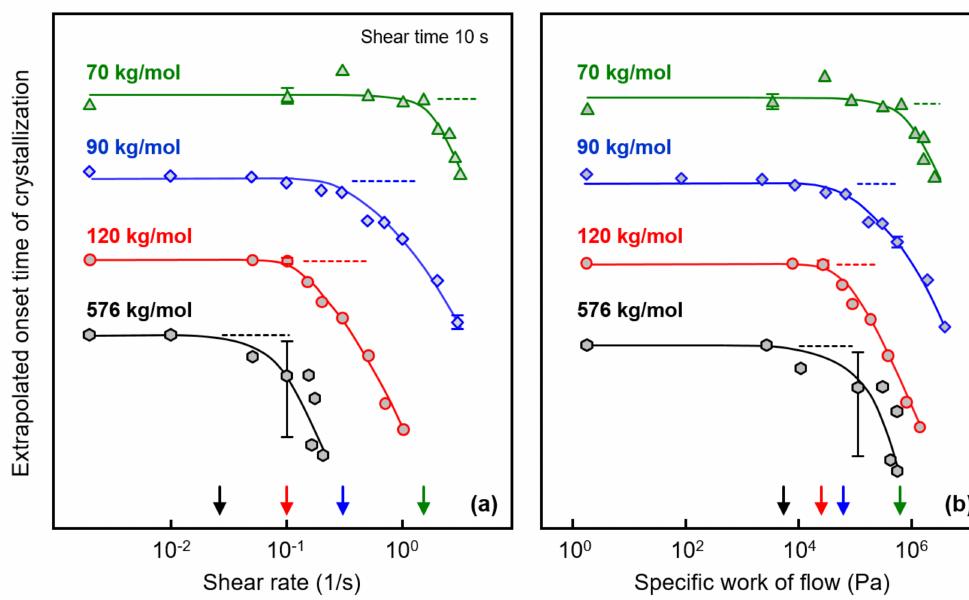
Figure 4. Extrapolated onset time of crystallization of PLLA of different molar mass as a function of the shear rate ( a ) (left) and as a function of the specific work of flow ( b ) (right). The dashed lines indicate zero-shear onset times, and the arrows at the shear-rate/specific-work-of-flow axes indicate critical conditions above which shear-induced crystal nucleation occurs. Error bars are shown for selected data only, being typically lower than the symbol size for the Corbion-grade samples (70, 90, and 120